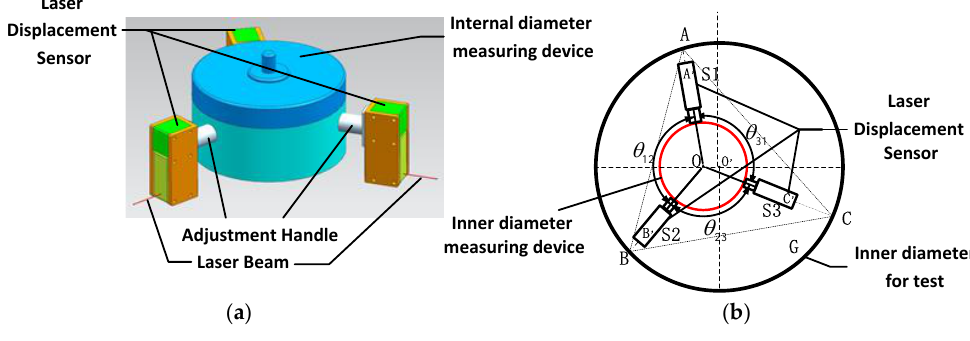
Figure 1. ( a ) Physical model; ( b ) Theoretical model.